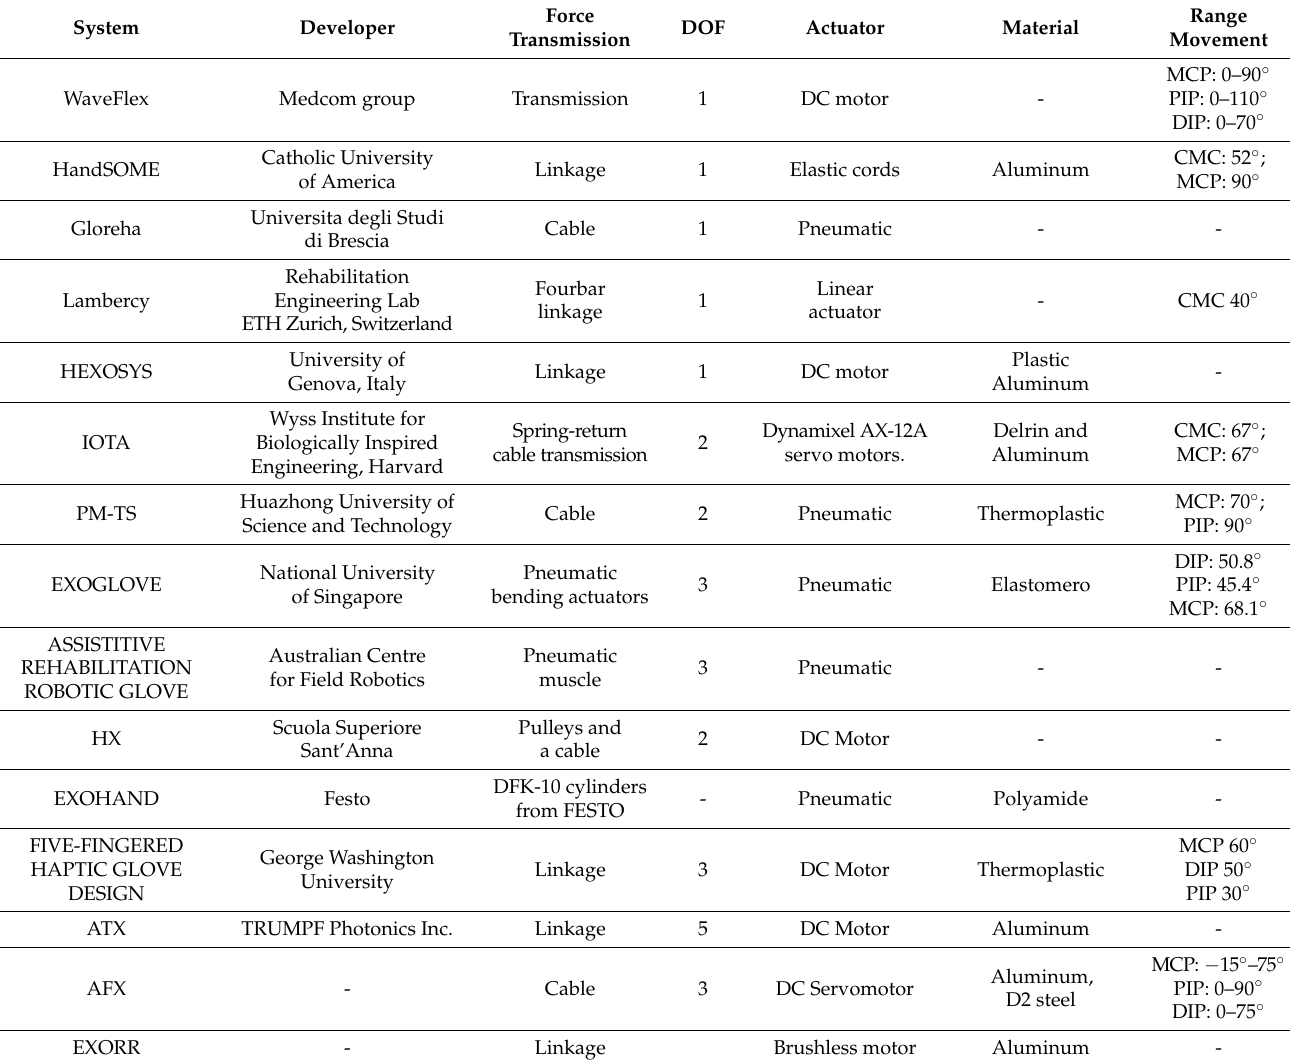
Table 1. Review of exoskeleton for hand